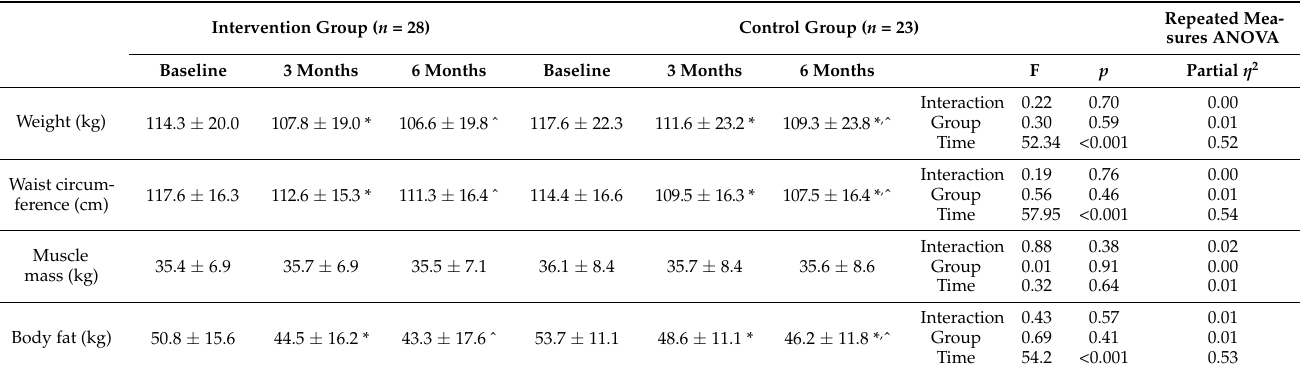
Table 3. Descriptive and inferential statistics of the 6-month complete cases (repeated measures ANOVA).